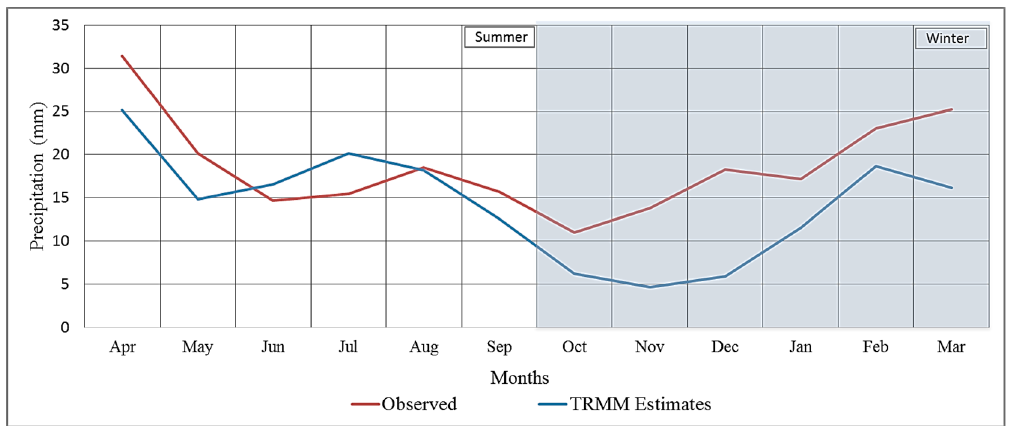
Figure 4. Average TRMM estimates and gauge data for mean monthly rainfall for all stations with seasonal demarcation.